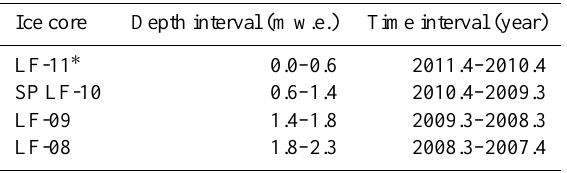
Table 2. Synthetic ice core construction using the different Lomonosovfonna shallow cores (LF-08 and LF-09) and SP LF-10 snow